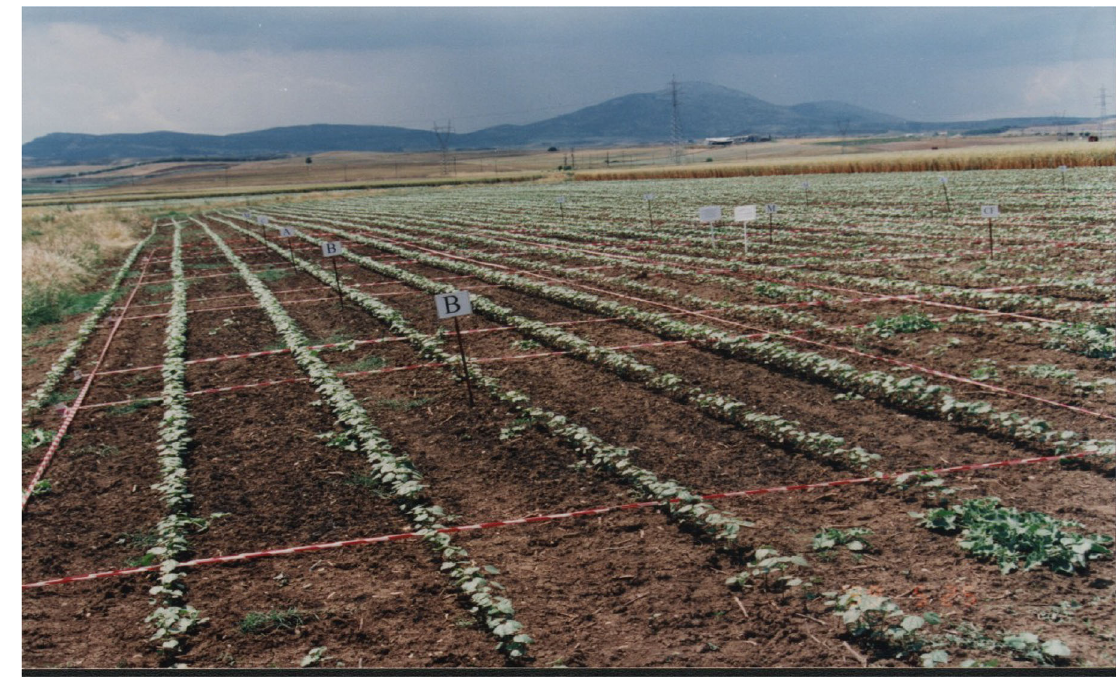
Fig. 4 Experiment with sewage sludge application in cotton crop in Magnesia area, central